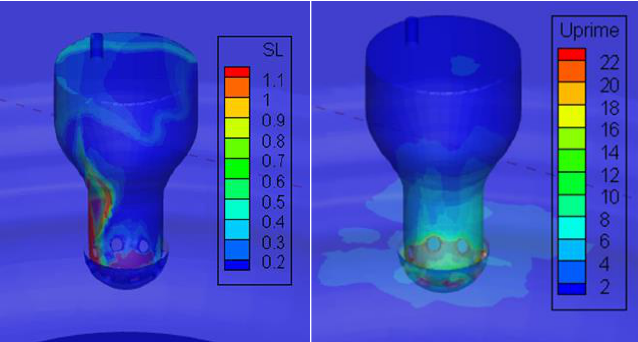
Figure 6. Laminar flame speed (m/s) and velocity fluctuation in the pre-chamber.